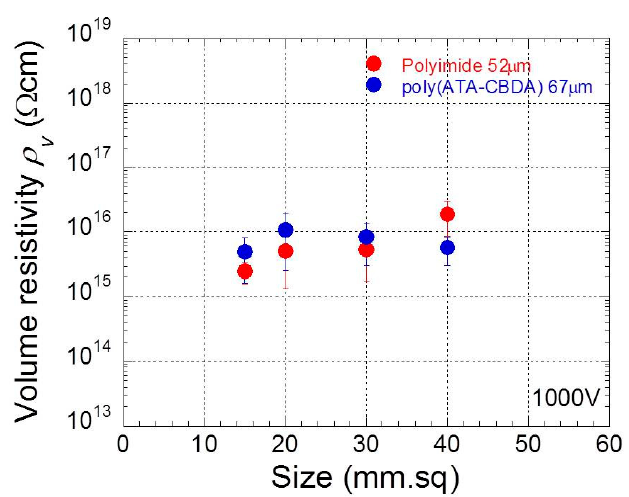
Figure 3. E ff ect of film size on electric resistivity at 1000 V for polyimide and biopolyimide films.